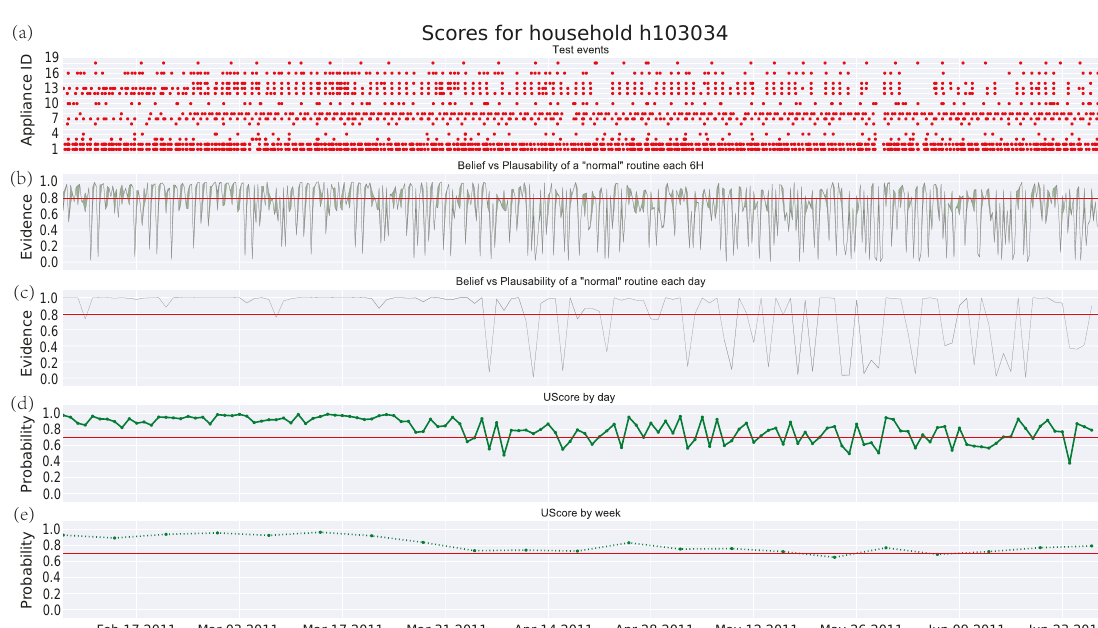
Figure 4. Score for test events in household No. 103034 from HES dataset: ( a ) test events; ( b ) DST score every 6 h; ( c ) DST score by day; ( d ) union probability score by day; and ( e ) union probability score by